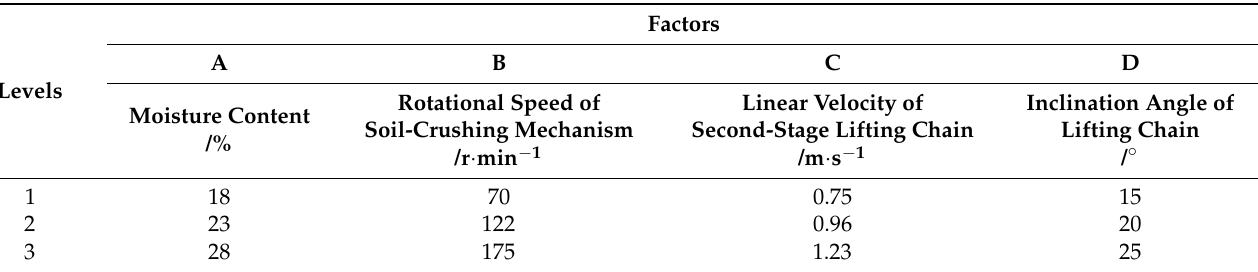
Table 2. Coding with factors and